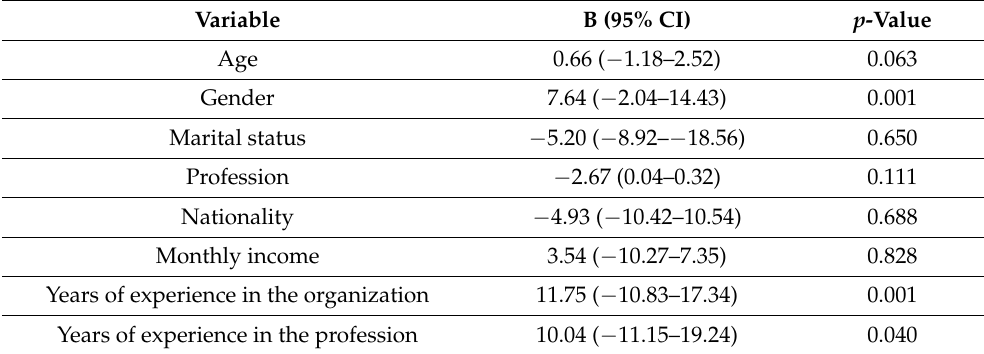
Table 3. Multiple linear regression factors associated with the telehealth readiness of healthcare